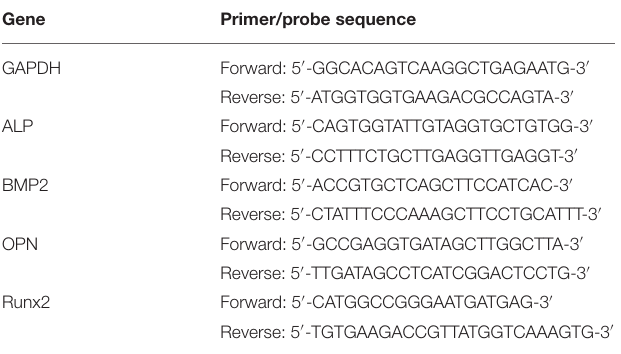
TABLE 2 | Primer sequences for osteogenesis-related genes for real-time PCR. Gene Primer/probe sequence